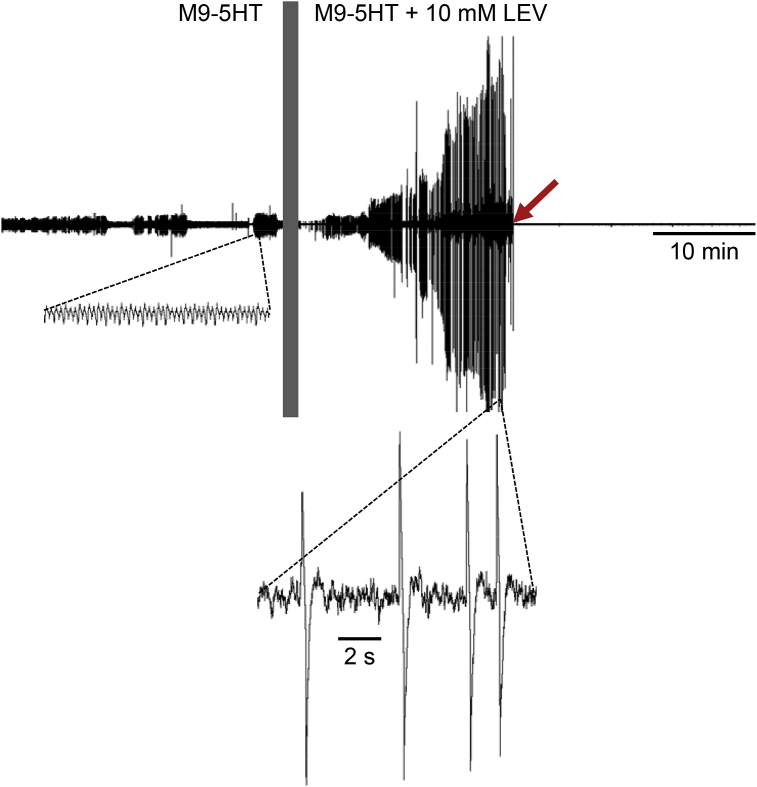
LEV-induced paralysis expels worm through worm trap. Trace shows a representative EPG recording from an N2 worm; vertical bar marks perfusate switch from M9-5HT to 10 mM LEV in M9-5HT. During baseline, the EPG signal was of normal amplitude (inset) (in this example, baseline pumping had gaps). Following the switch to LEV, EPG signal amplitude increased (inset), followed by loss of the signal (red arrow) when the worm was expelled from the chip's recording module into the waste reservoir. All traces are shown at the same vertical scale. (For interpretation of the references to color in this figure legend, the reader is referred to the Web version of this article.)